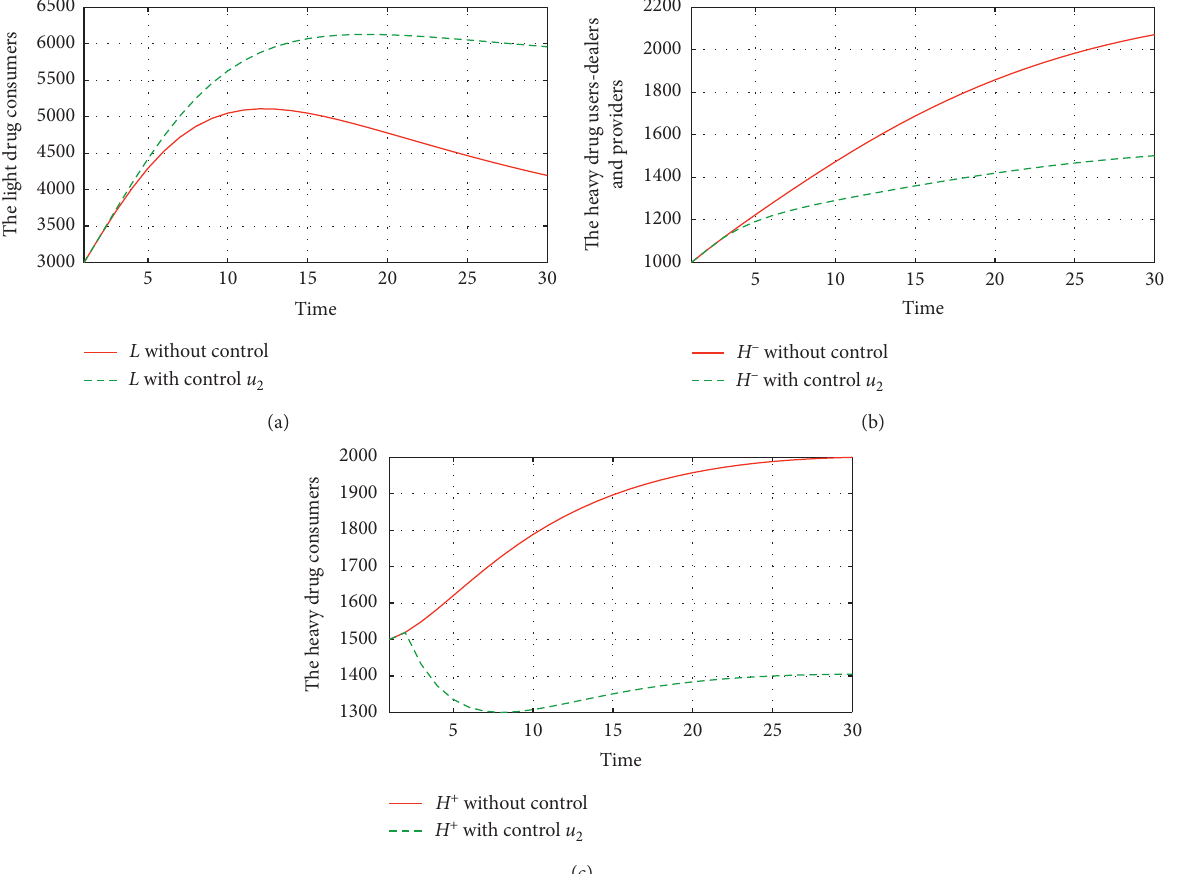
Figure 3: (a) The evolution of L with and without controls. (b) The evolution of the H - with and without controls. (c) The evolution of the H + with and without controls.